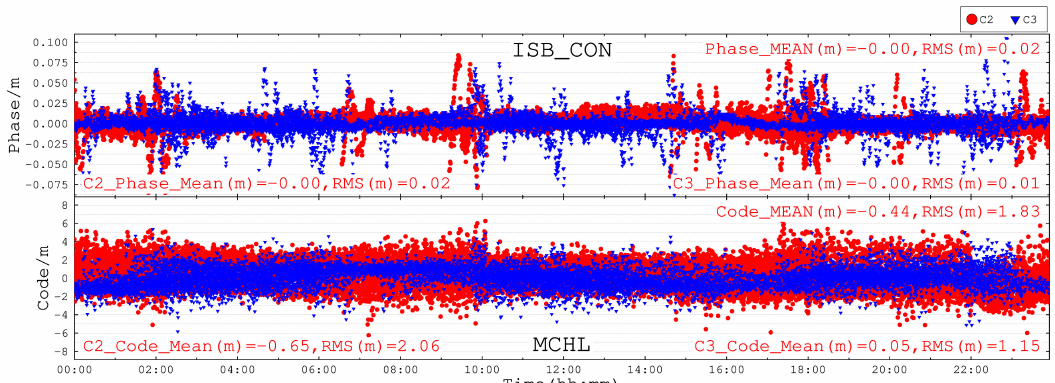
Figure 21. The residuals of BDS-2 and BDS-3 code and carrier-phase observations with the ISB_CON scheme at station MCHL, DOY 097, 2020.